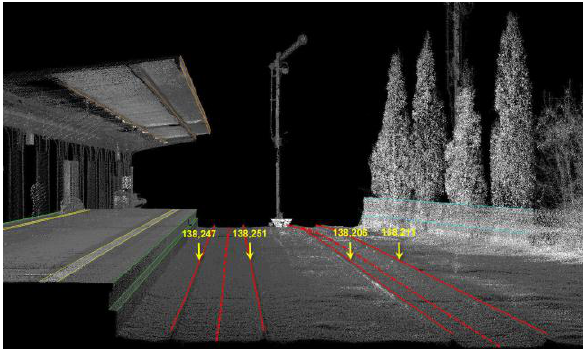
Figure 11: Determination of the super elevation of the used track and of neighbouring track Along this track axis the test profile can be moved though the points to detect the clearance violations. This task can be fulfilled with software packages like SiRailScan or TerraScan mentioned above.